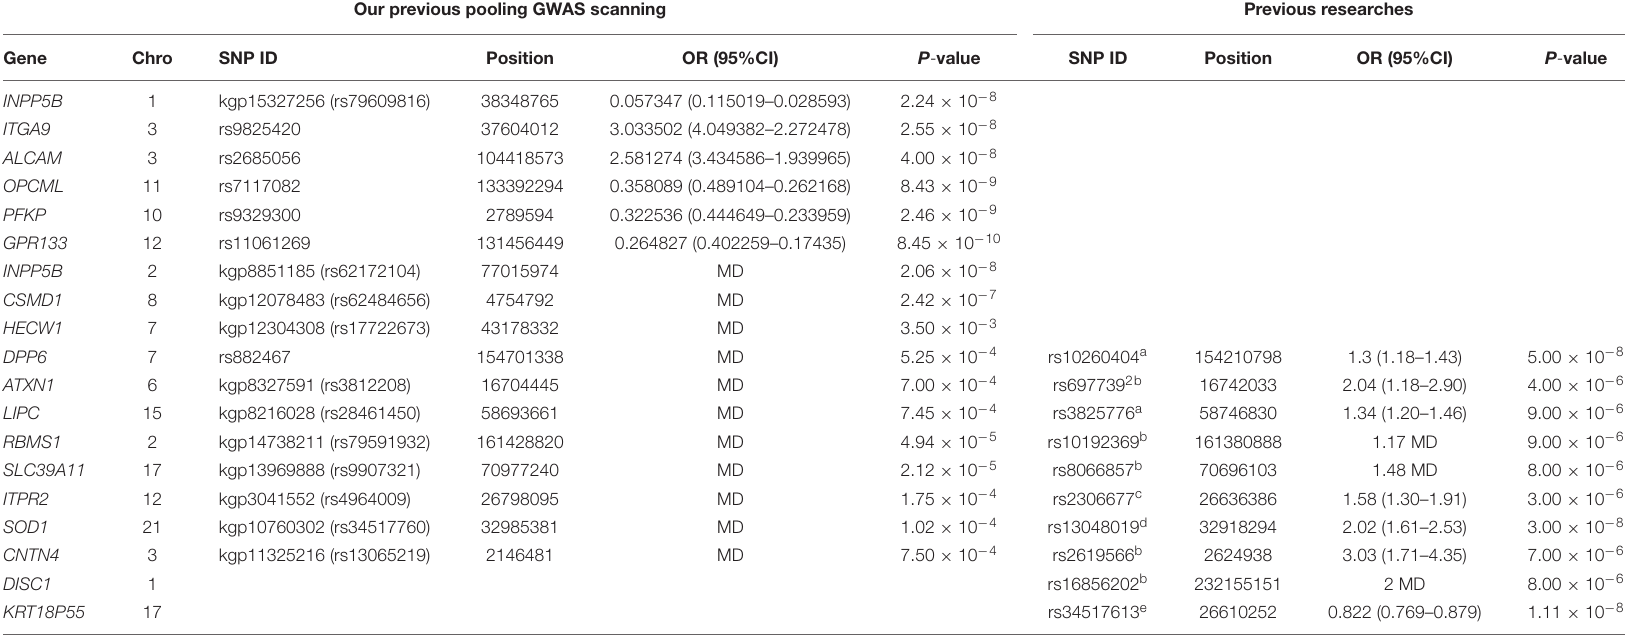
TABLE 1 | All SNPs were chosen in the association